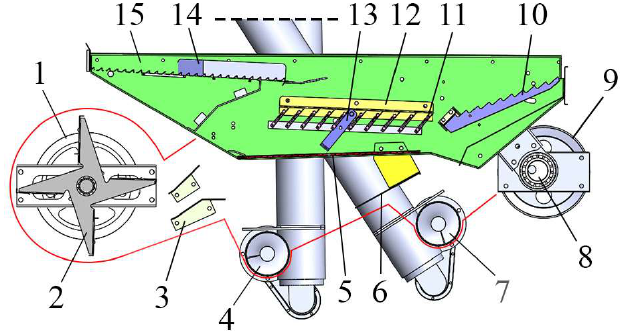
Figure 8. Schematic diagrams of the structure of the combined cleaning unit: (1) Centrifugal wind machine power input belt. (2) Centrifugal divider. (3) Wind guide. (4) Primary seed screw conveyor. (5) Woven sieve. (6) Seed skid. (7) Secondary miscellaneous residual screw conveyor. (8) Eccentric bearing. (9) Vibrating screen power input pulley. (10) Tail sieve. (11) Fish scale sieve. (12) Fish scale sieve fixed plate. (13) Fish scale sieve opening adjustment device. (14) Shaking plate. (15) Vibrating screen housing.